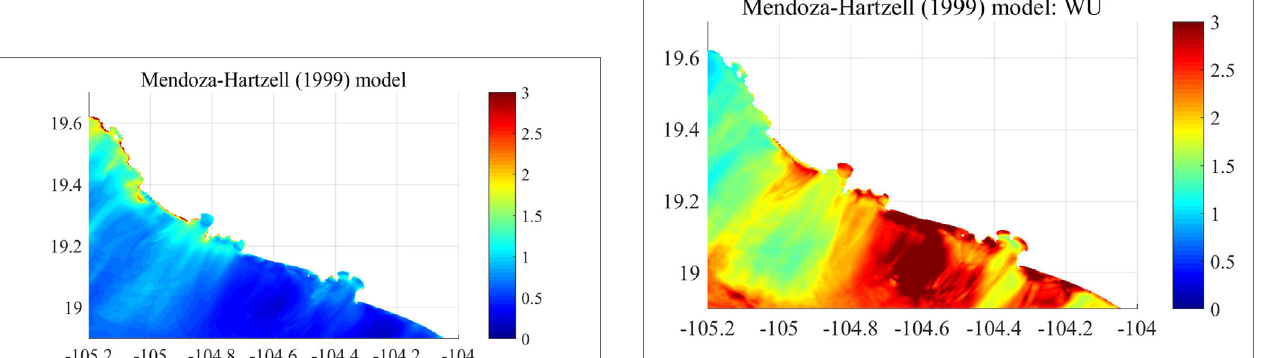
FigUre 7 | Maximum surface elevation, in meters, of the 1995 Colima Earthquake Tsunami based on the Mendoza–Hartzell model.